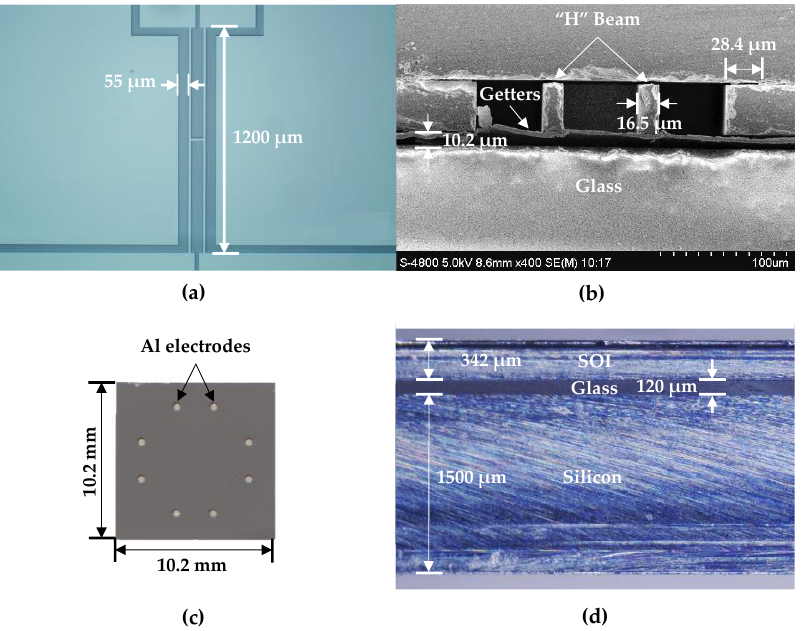
Figure 6. The fabrication results: ( a ) top view of the “H” resonant beam; ( b ) an SEM cross-section image of the microsensor; ( c ) top view of the microsensor and ( d ) side view of the microsensor.